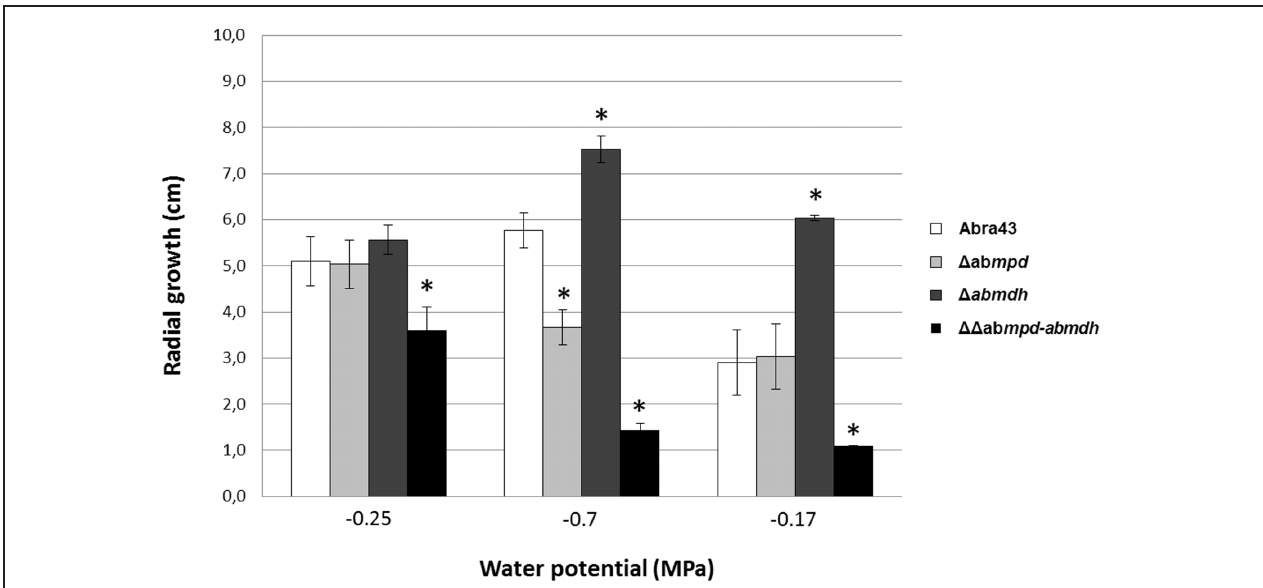
FIGURE 7 | Effect of low water potential treatments on the mycelium radial growth of the A. brassicicola wild-type strain and mannitol-metabolism mutants. In vitro growth tests were carried out on PEG-infused plates (Verslues et al., 2006). Colony diameters (cm) were